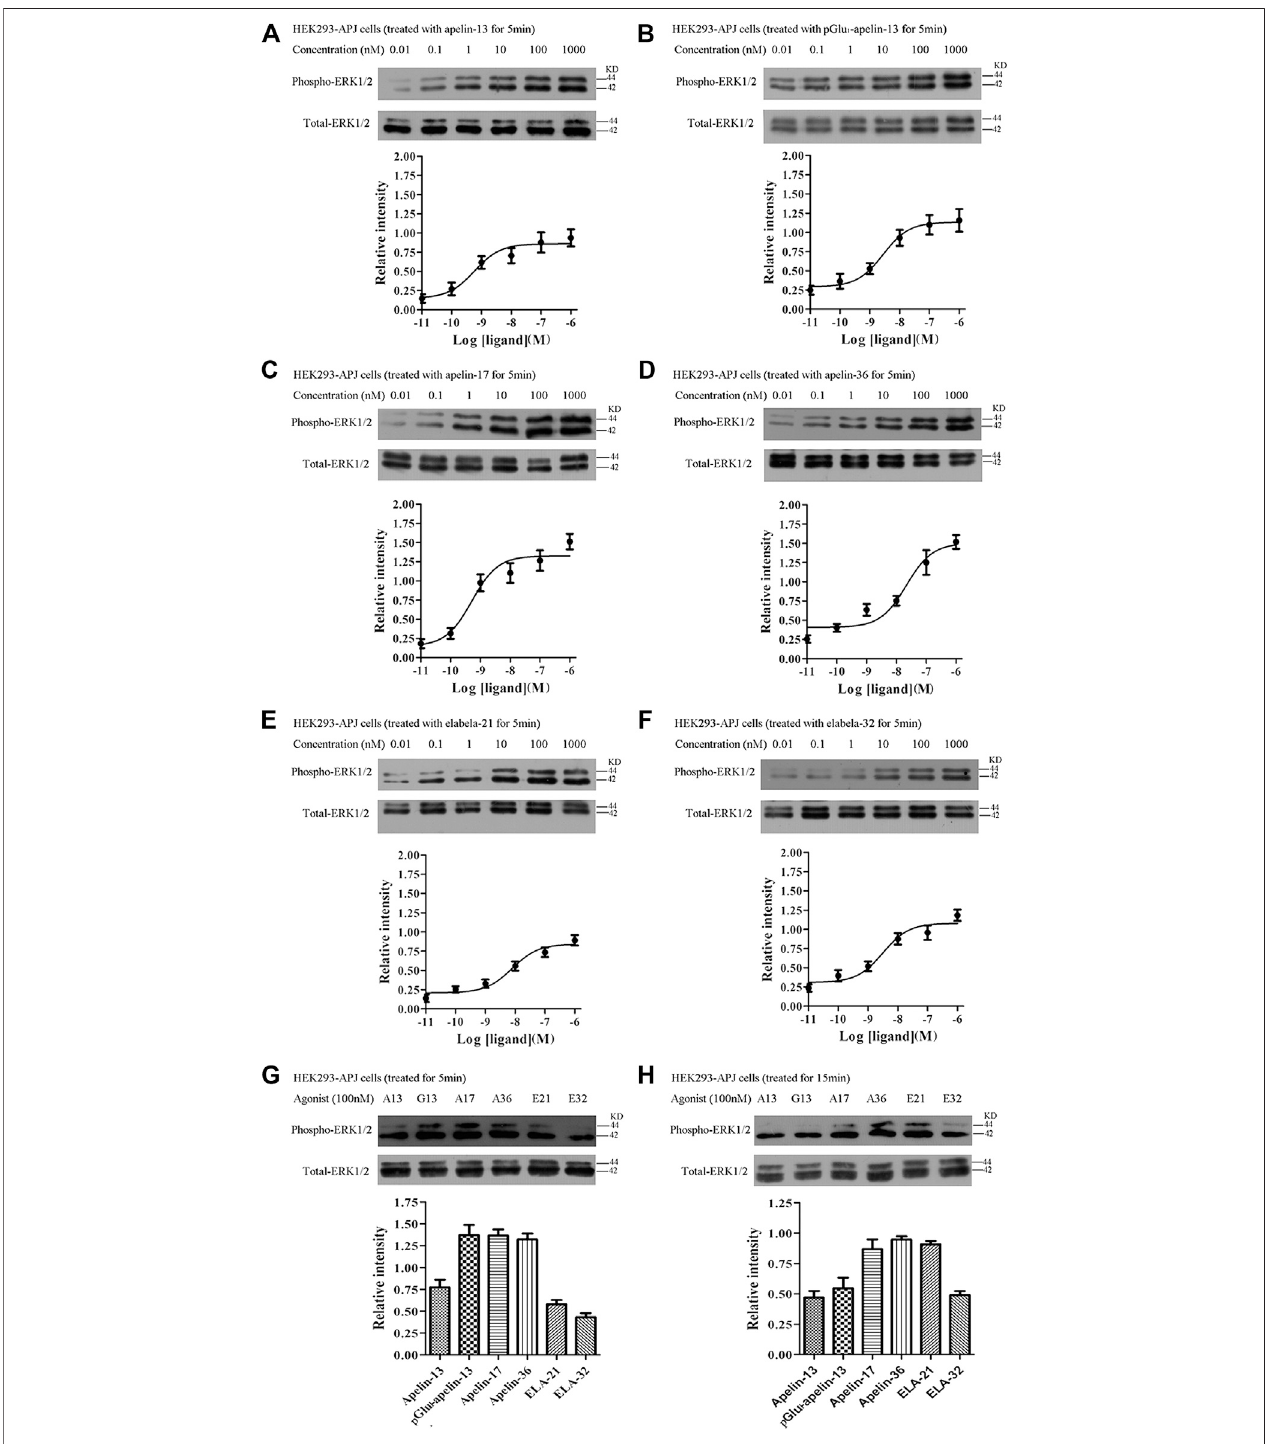
FIGURE 4 | Changes of ERK1/2 phosphorylation in HEK293 cells with stable expression of APJ: (A – F) after 5-min stimulation by the six agonists in different concentrations (0.01 – 1,000 nM) (G and H) ERK was measured after 5 or 15 min stimulation with six peptides at a concentration of 100 nM. Levels of p-ERK, total ERK were determined by Western blot. The data represent means ± SEM of four independent experiments.